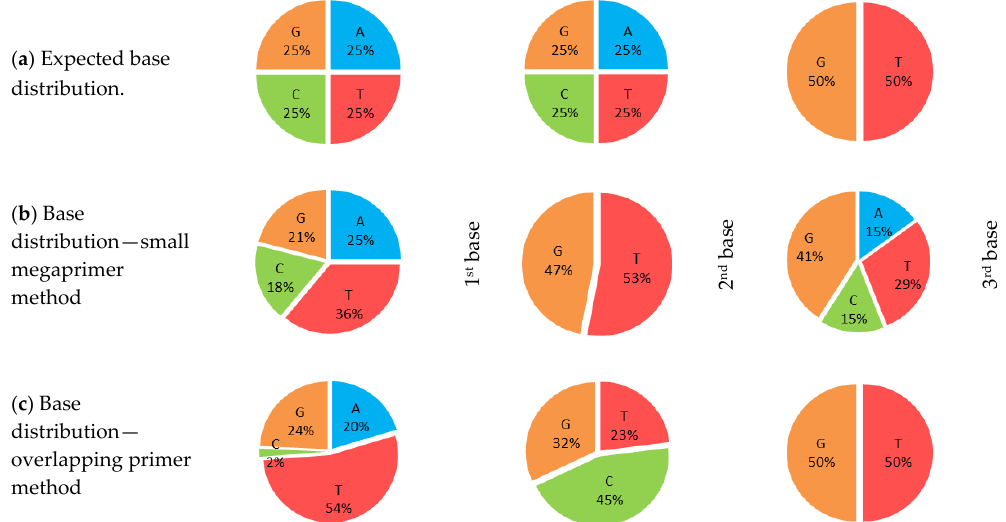
Figure 2. Nucleotide-base distribution within randomized position 460 of Pc PAL. ( a ) Theoretical, expected distribution for NNK-degeneracy, with the four bases (A, T, G, C) equally represented in the first two nucleotides, while G, T having the same ratio within the third position); ( b ) experimental base-distribution from the small megaprimer-transformant library; ( c ) experimental base-distribution from the transformant library obtained by the partially overlapping primers mutational strategy. For